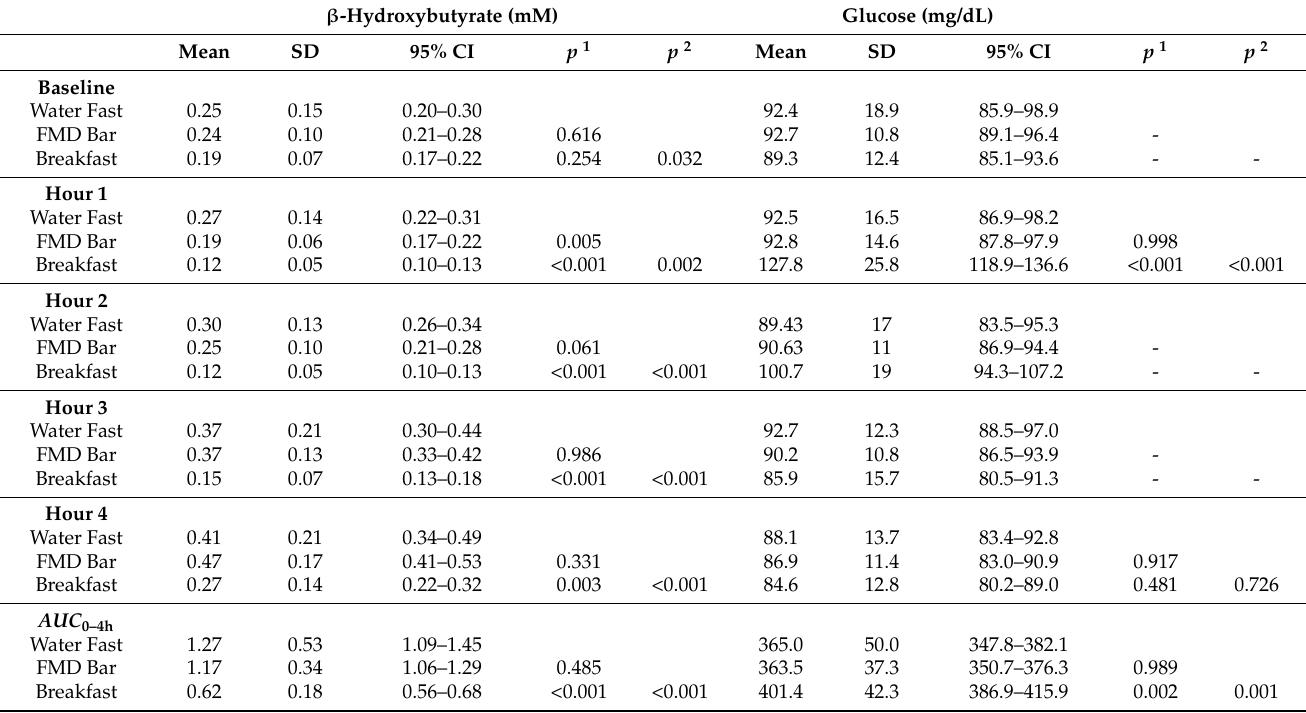
Table 3. Beta-hydroxybutyrate (BHB) and glucose levels.